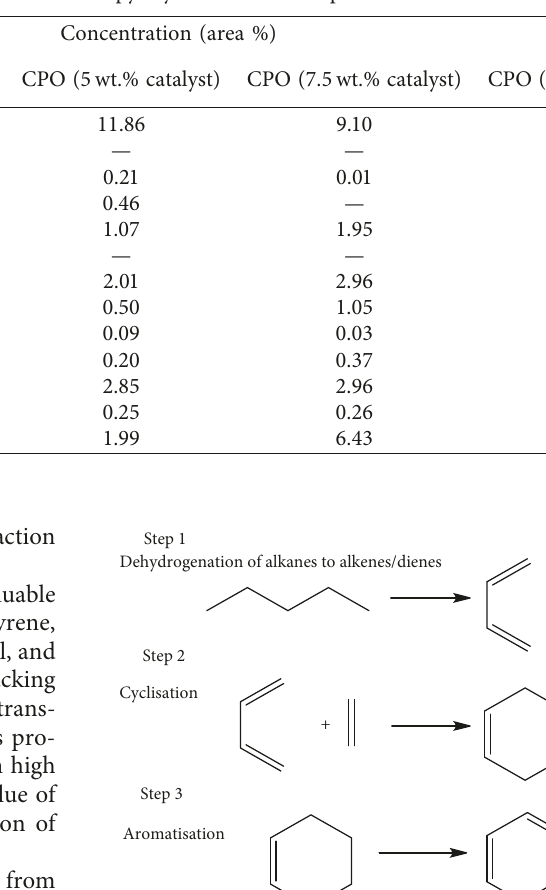
Table 7: Influence of zeolite NaY on pyrolytic oil chemical